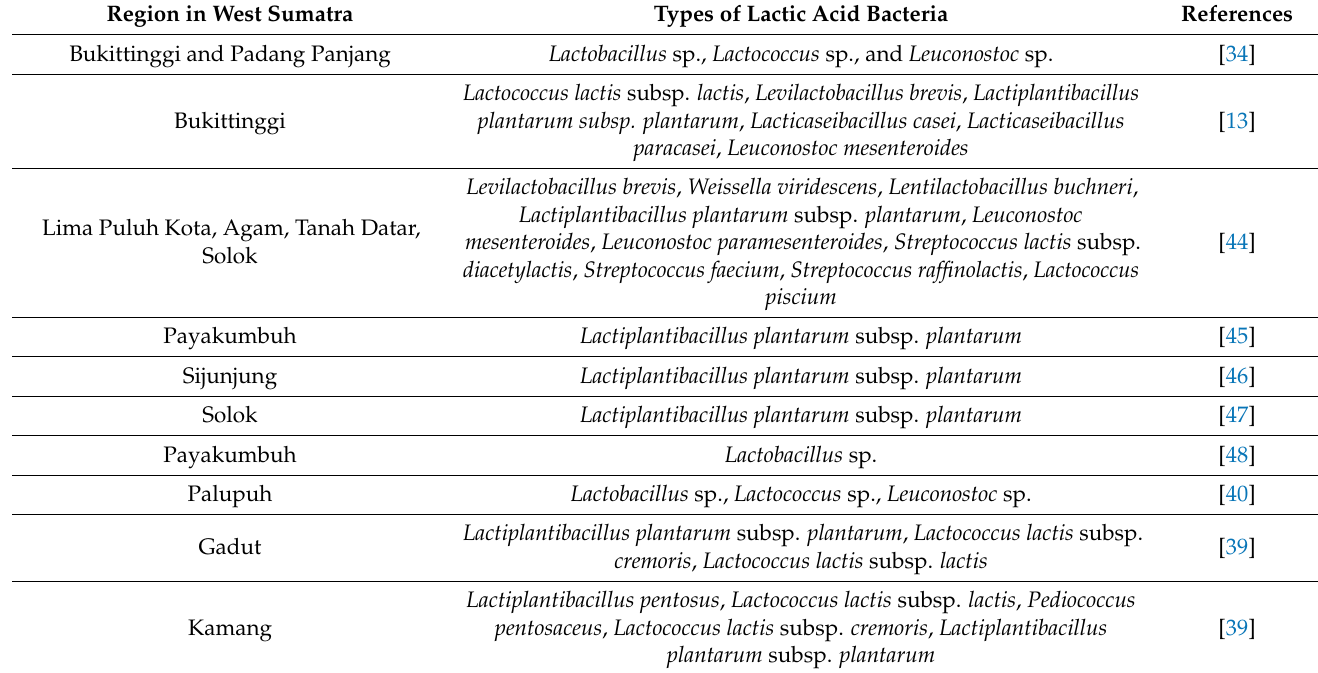
Table 2. Types of lactic acid bacteria found in dadih —fermented buffalo milk. Region in West Sumatra Types of Lactic Acid Bacteria